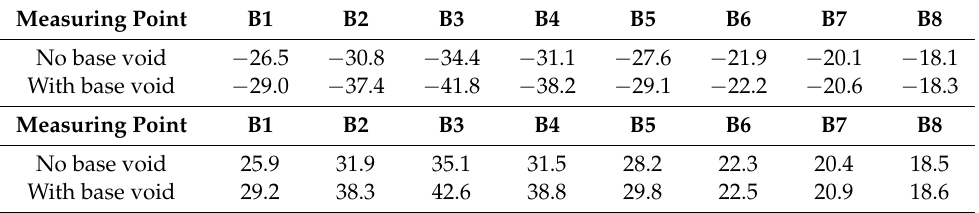
Table 5. Peak stress at each measuring point of the tunnel invert (kPa).